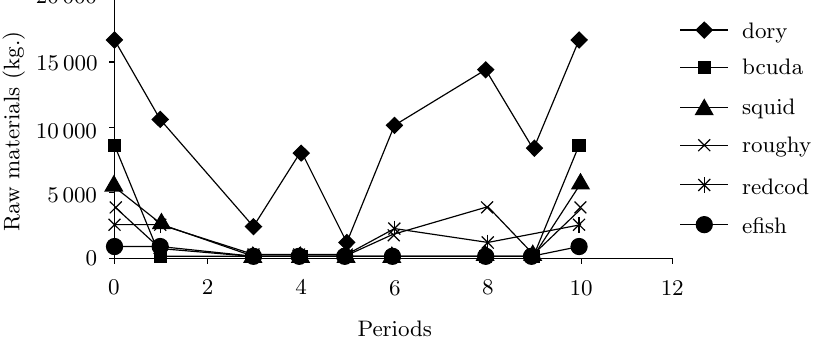
Figure 2: Inventory levels of each species in different periods.